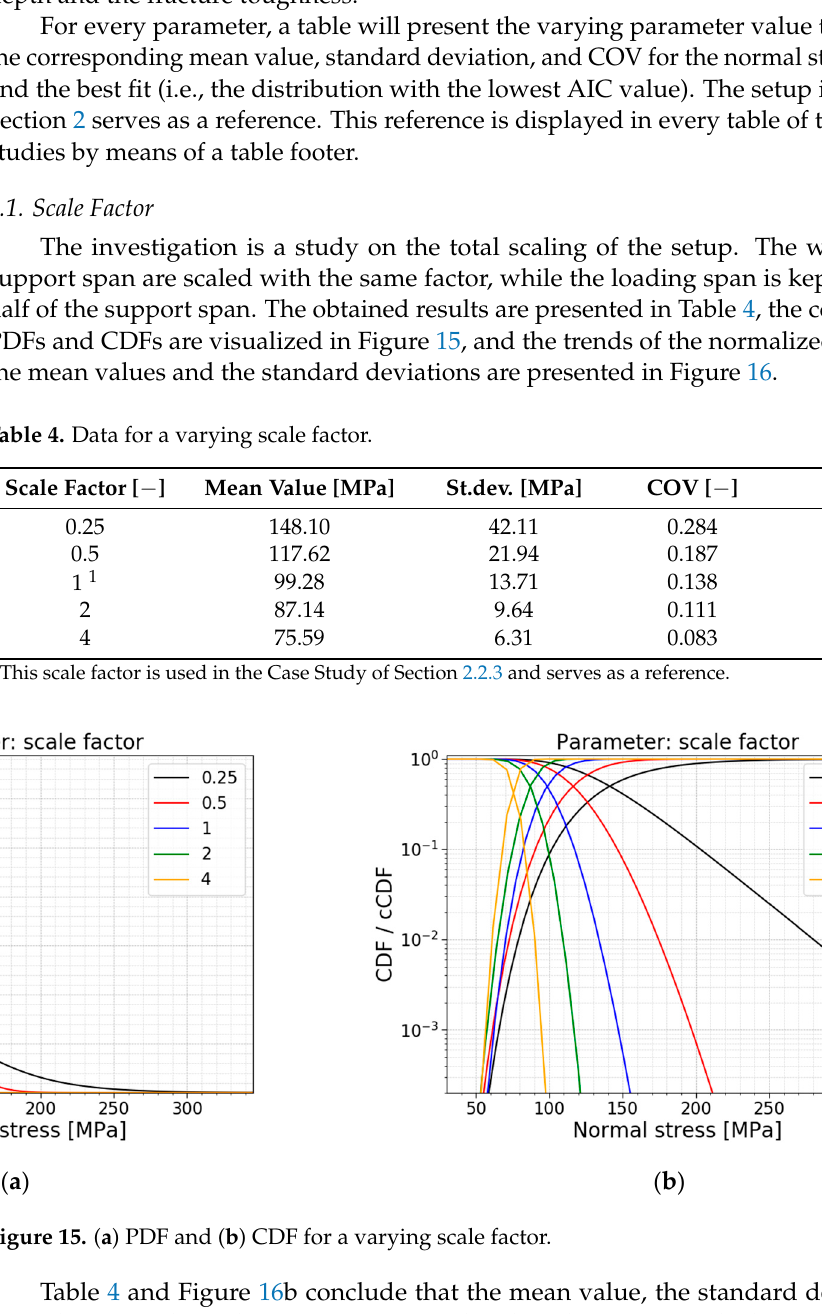
Figure 14. ( a ) PDFs and ( b ) CDFs of the competing models with the outcome data.